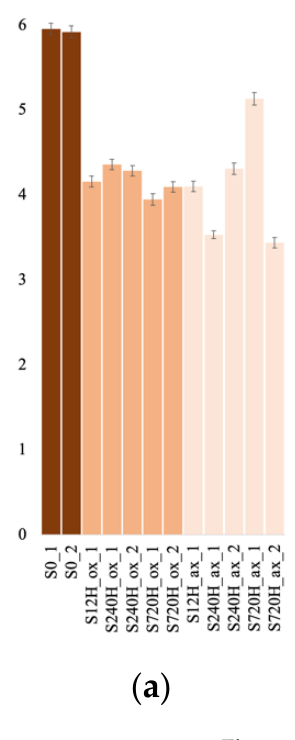
Figure 6. Shannon diversity indices for the archaeal ( a ) and bacterial ( b ) communities, in the oxic (ox) and anoxic (ax) incubations, in the sediment (S) and water (W) samples and for both duplicates (_1 and _2). S0, initial sediment before incubation; Dam, dam lake water sample.